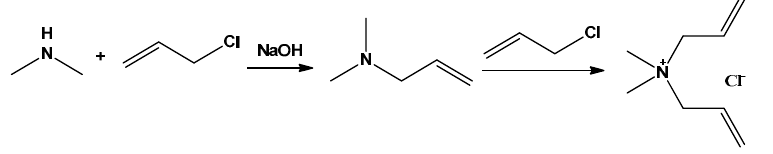
Figure 2. Synthesis routine of DMDAAC.